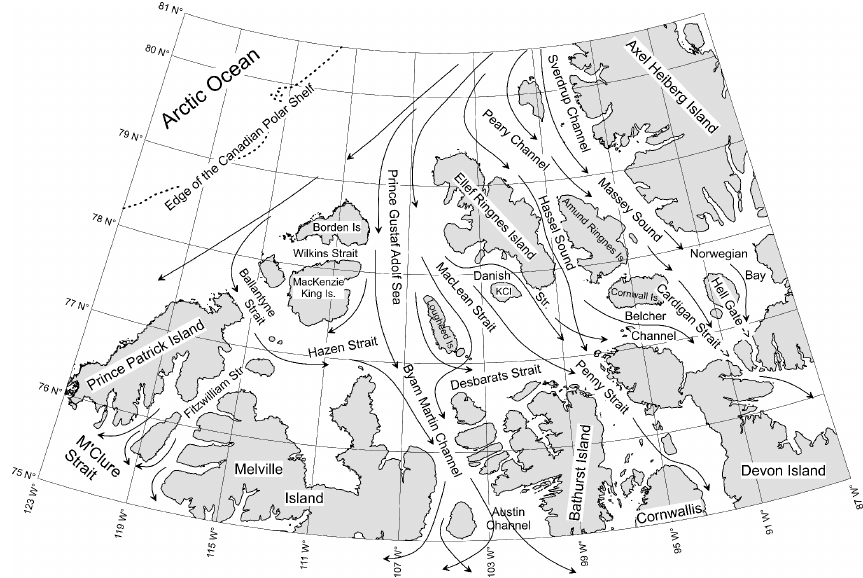
Figure 1. The northern part of the Canadian polar shelf, its principal geographic features and the schematic pattern of sea-ice movement across it. The map encompasses the Queen Elizabeth Islands which overly the feature known to geologists as the Sverdrup (sedimentary) Basin.